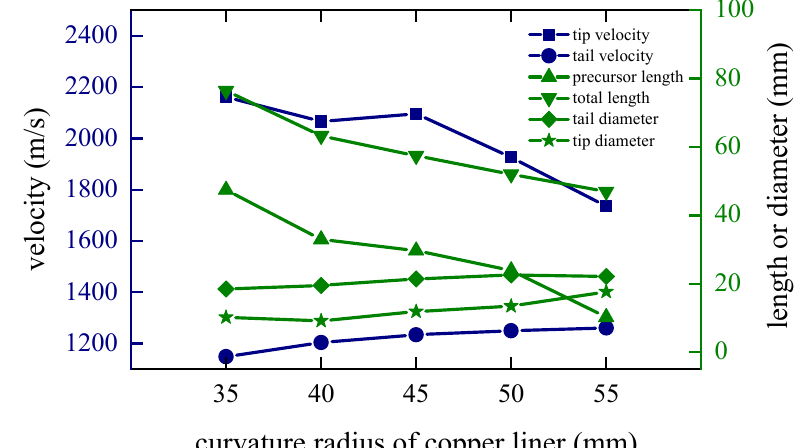
Figure 13. Curves of coating EFP shape parameter change.